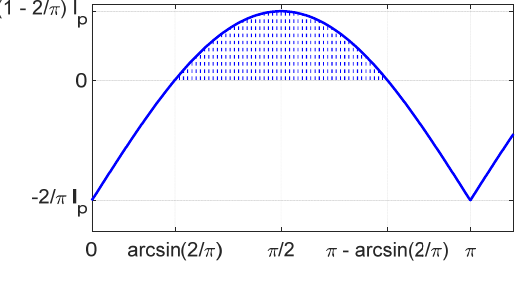
Figure 9. Alternate component of i r,out .